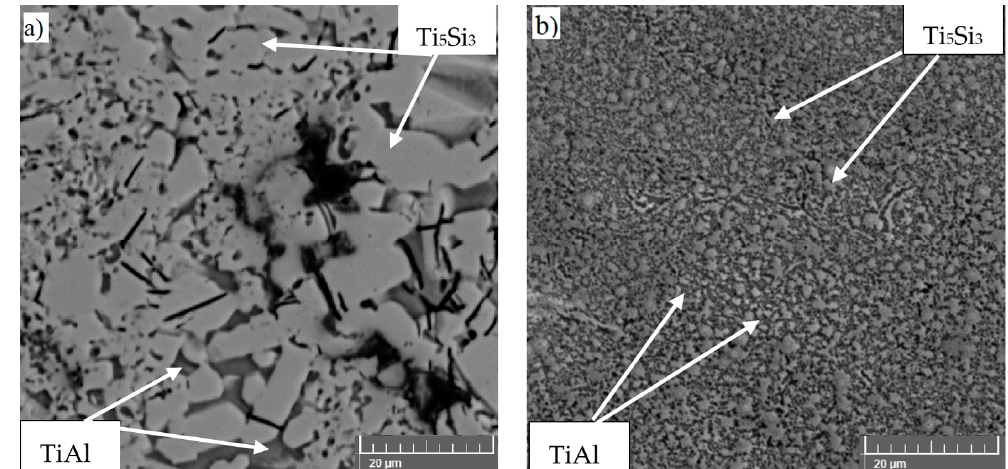
Figure 4. Microstructure of TiAl10Si20 prepared by: ( a ) reactive sintering + spark plasma sintering (RS + SPS), ( b ) mechanical alloying + spark plasma sintering (MA + SPS).